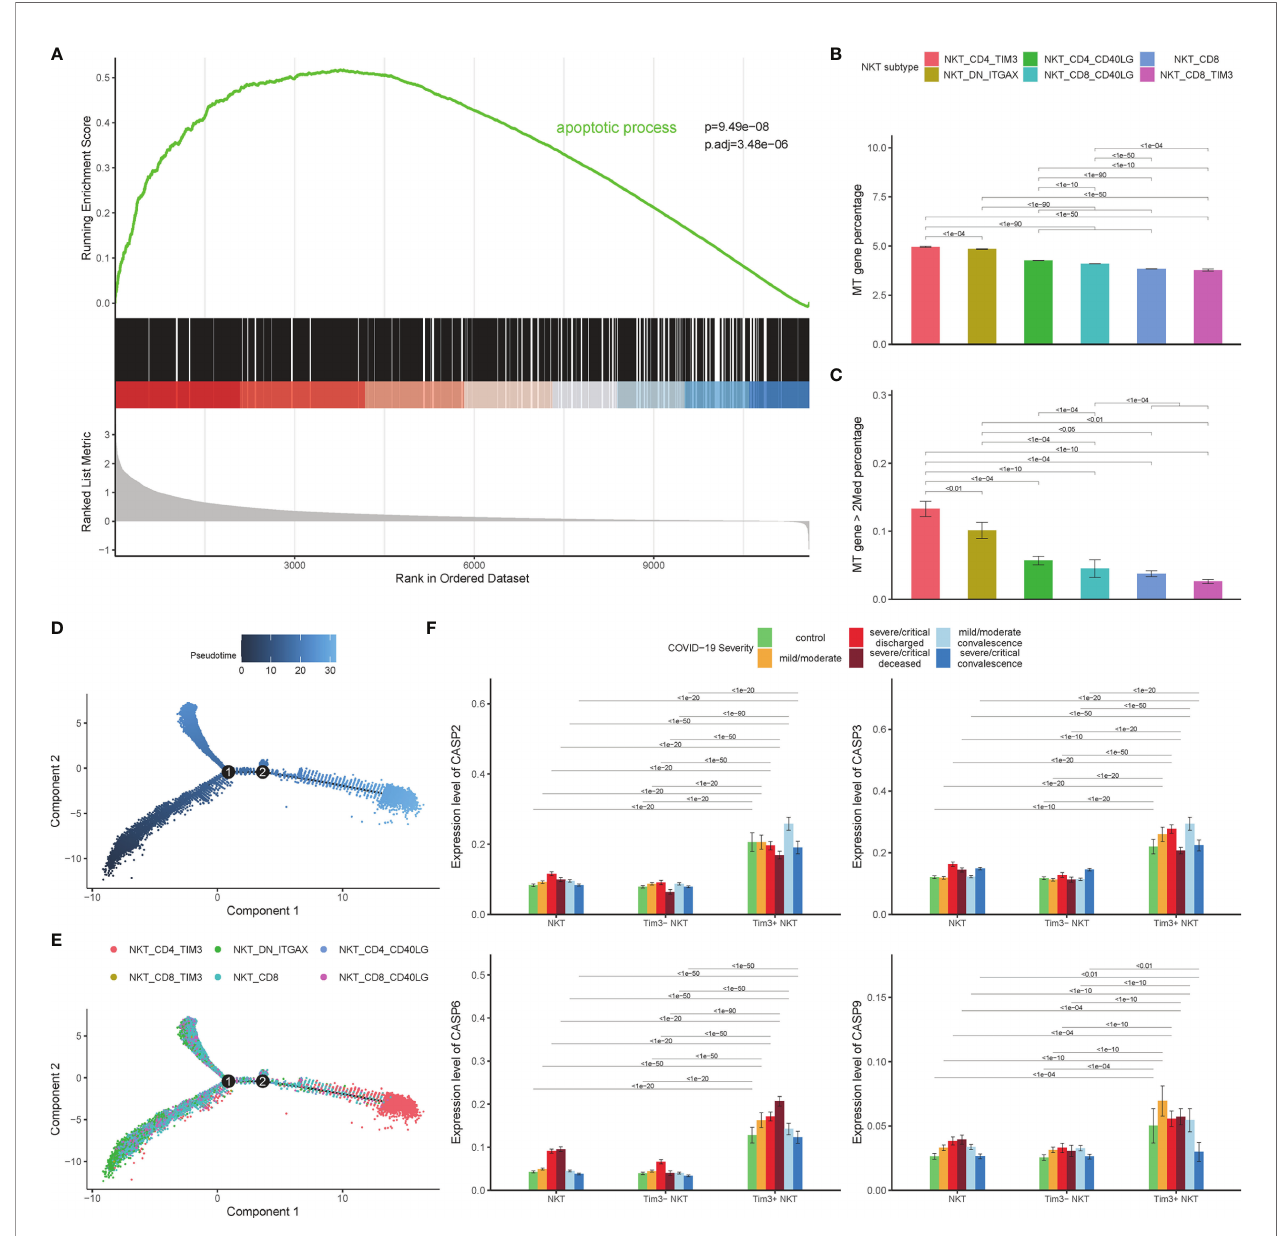
FIGURE 4 | Tim-3 expression associated with NKT cells apoptosis in COVID-19. (A) Gene set enrichment analysis (GSEA) result of apoptotic process pathway. (B) Expression of mitochondrial genes on 6 NKT cell clusters. (C) Percentage of mitochondrial genes highly expressed NKT cells on 6 NKT cell clusters. (D, E) Pseudo-time analysis results. (F) Expressions of caspase genes on Tim-3+ NKT cells and Tim-3- NKT cells in COVID-19 patients and controls. (Wilcoxon